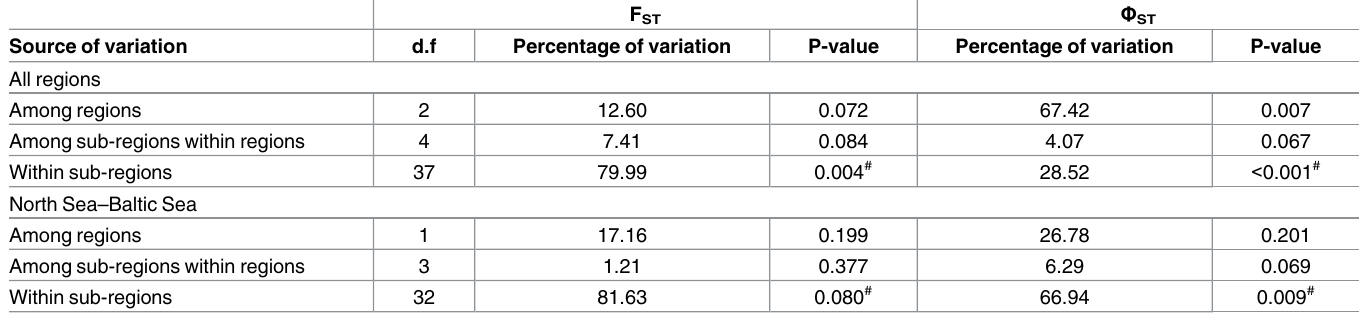
Table 5. Results of AMOVA for the mitochondrial haplotypes for F ST and Φ ST indices, performed for all regions, and the North Sea to Baltic Sea sub-regions.